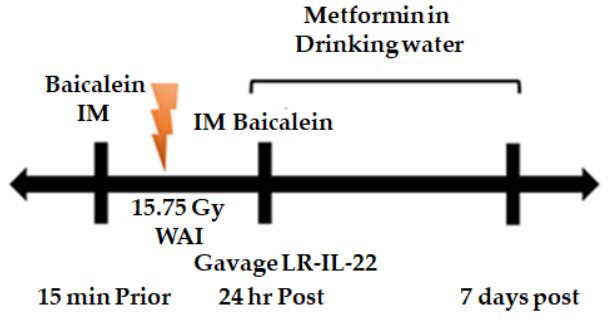
Figure 1. Experimental Paradigm: Small molecule radiation mitigator and probiotic LR-IL-22 ad- ministration prior to and following 15.75 Gy WAI. Small molecule mitigators utilized in survival studies include intramuscular Baicalein administered 15 min prior to WAI and 24 h following WAI, Metformin administered orally in drinking water for 7 day following WAI and LR-IL-22 gavaged 24 h following WAI.